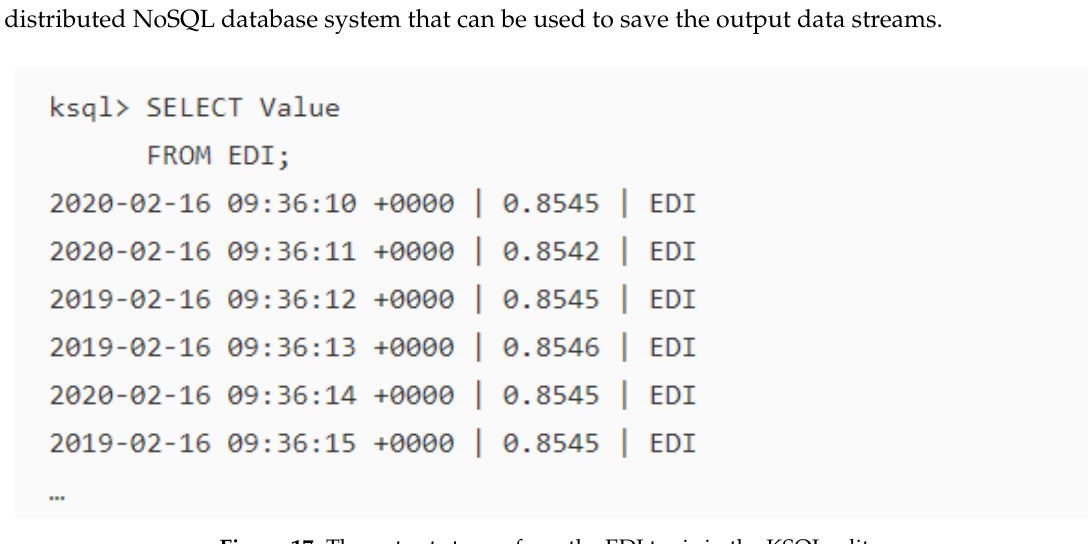
Figure 17. The output stream from the EDI topic in the KSQL